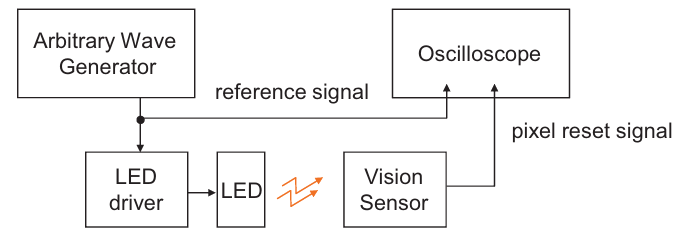
Figure 16. Block diagram of the experimental